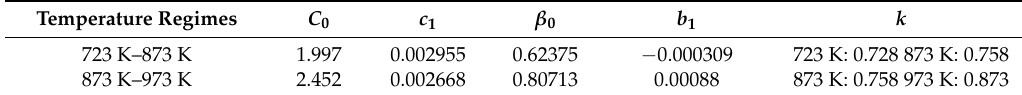
Table 1. The coefficients of Equation (38).